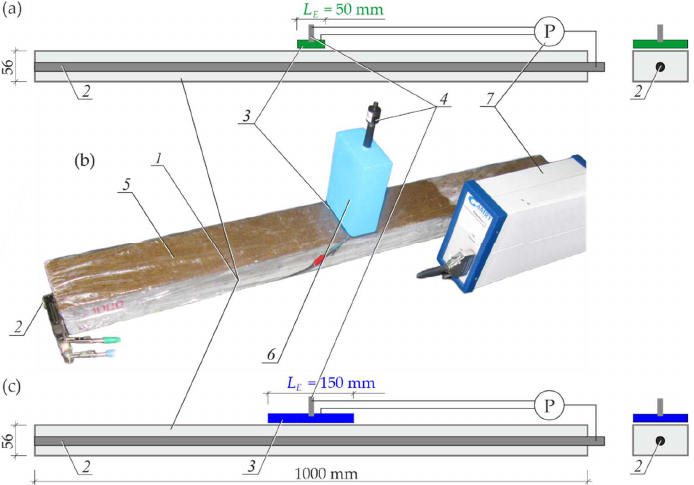
Figure 8. The test stand for verification of the iterative method for determining the polarized area of reinforcement during the EIS tests on reinforced concrete: ( a ) longitudinal and transverse sections of the system with a shorter auxiliary electrode, ( b ) a photo of the test stand, ( c ) longitudinal and transverse sections of the system with a longer auxiliary electrode; 1—concrete test element, 2—working electrode, 3—counter electrode, 4—reference electrode, 5—felt, 6—ballast, 7—potentiostat. The spectrum P1 L obtained for the longer counter electrode L E = 246 mm was re- garded as the initial spectrum for the test element of series S1 , while for the test element of series S2, the optimum spectrum for model simulations was the spectrum P4 L obtained for the counter electrode length L E = 100 mm. Then, electrochemical parameters for con- crete and steel were determined for the adopted electrical equivalent circuit (Figure 7) for both spectra P1 L and P4 L , using the method of iterative fitting. These values are shown in Table A2, Appendix C. Matching model spectra to the experimental ones using the coef- ficient described by Equation (11), the value of 1.14 was obtained for the element of series S1 , and = 0.96 for the element of series S2 (Table A2). \ Similarly to the modelled effect of the counter electrode width, the 2nd stage of the analysis provided predicted distributions of model spectra that showed the effect of a de- creasing length of the counter electrode after entering into Equations (8)–(10) electrochem- ical parameters determined from Table A2—Figure 6a,b. Dashed lines in Figure 6a illustrate distributions of model spectra of the element of series S1 obtained from the counter electrodes of L E = 200, 150, 100 and 50 mm in length, at the average mass moisture of concrete w mid = 4.8%. The spectra in Figure 6b show the spectra of the element of series S2 corresponding to the following lengths: L E = 246, 200, 150 and 50 mm, obtained at the measured average moisture content in concrete w mid = 5.0%—cf. Table 2. The solid line in Figure 6b presents the adjusted model spectra M2 L , M3 L , M4 L and M5 L of the test element of series S1 , while spectra M1 L , M2 L , M3 L and M5 L in Figure 6d refer to the element of series S2 . As in the previous analysis of the impact of the counter electrode width, the adjusted model spectra are additionally shown on the Bode plots— Figure 6g,h. Additionally, in this case, matching of model spectra to the theoretical ones was adjusted by the iterative method specifying the theoretical mass moisture of concrete, which is presented in Table 2 as an increase Δw in moisture content against mass moisture, at which the initial spectra M1 L and M4 L were obtained. An increase in moisture content in concrete element of series S1 was observed within a relatively narrow range of +0.2– \